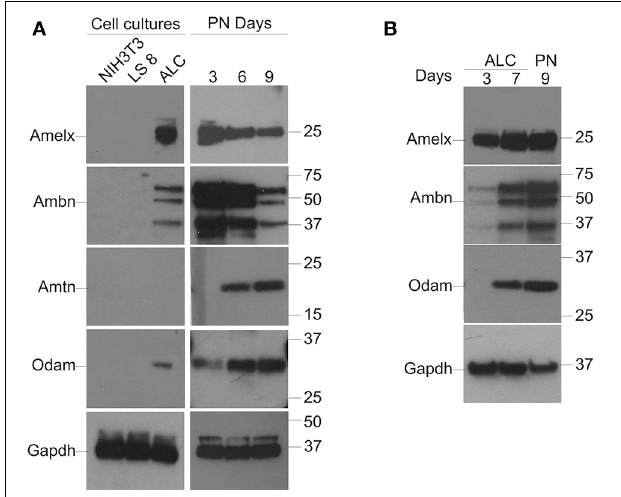
FIGURE 2 | Protein expression in LS8 and ALC cells, and in vivo mouse molars. (A) Groupings to left: Western blot analysis of the expression of Amelx,Ambn,andOdamisnotedinALCcellsonly.LS8cellsdidnotappearto express the enamel proteins examined. No Amtn expression was noted in either enamel organ cell line. NIH3T3 (fibroblasts) cells are used here as a negative control. All cells cultured for 7 days. Groupings to right: Protein from PN3, 6, and 9 mouse first molars were examined to confirm the suitability of eachantibodytoassessmouse-derivedenamelproteins;andalsotoillustrate the decreasing levels of Amelx and Amtn from PN3 to PN9, and the increasinglevelsofAmtnandOdamoverthesametimecourse. (B) Asecond seriesofWesternblotswerecompletedwithALCcellsisolatedatdays3and 7afterpassage,andalsofromPN9mousemolarstodirectlycompareprotein levels for Amelx, Ambn, and Odam in ALC cells when compared to in vivo derived tooth tissues. Glyceraldehyde-3-phosphate dehydrogenase (Gapdh) was used as a loading (normalizing) control.